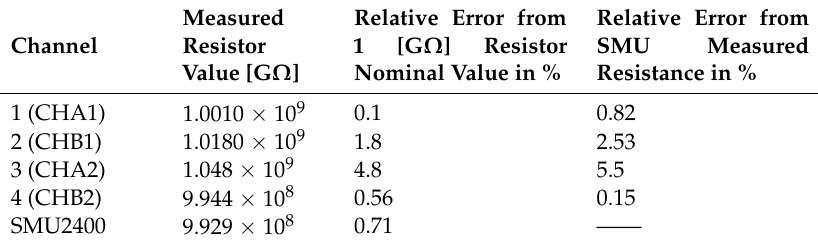
Table 5. Calibration results for all four channels of the Ten-Koh DLP